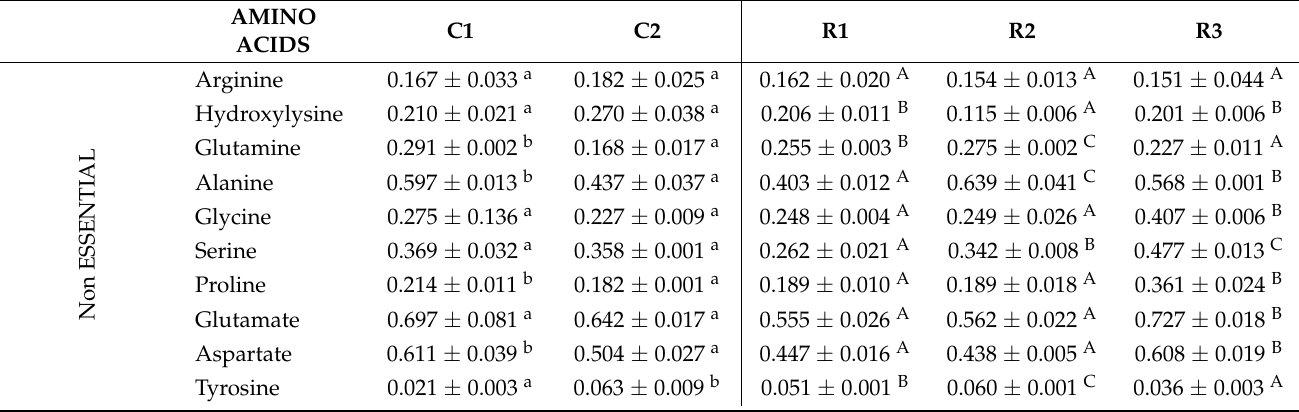
Table 3. Free amino acids’ contents in different fish sauces (g/100 mL). Different superscript letters between means within a row indicate statistically significant differences at p < 0.05. Lower-case letters are used for comparing C1–C2 (commercial samples); upper-case letters are used for R1–R2–R3 samples at 12-, 24-, and 48-month